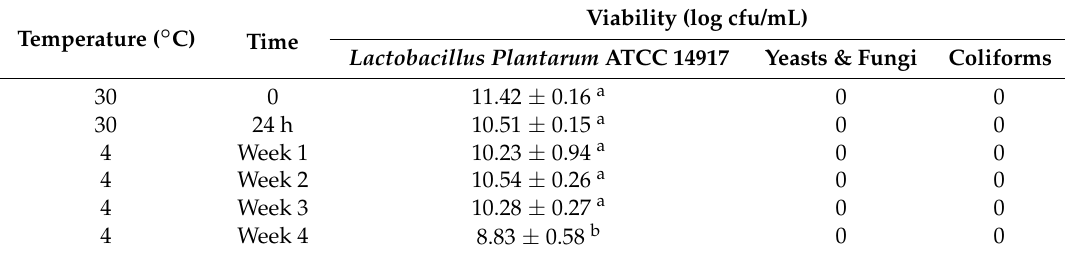
Table 1. Viability of the Lactobacillus plantarum ATCC 14917 cells in the fermented pomegranate juices after fermentation (24 h in 30 ◦ C) and over 4 weeks of storage at 4 ◦ C.